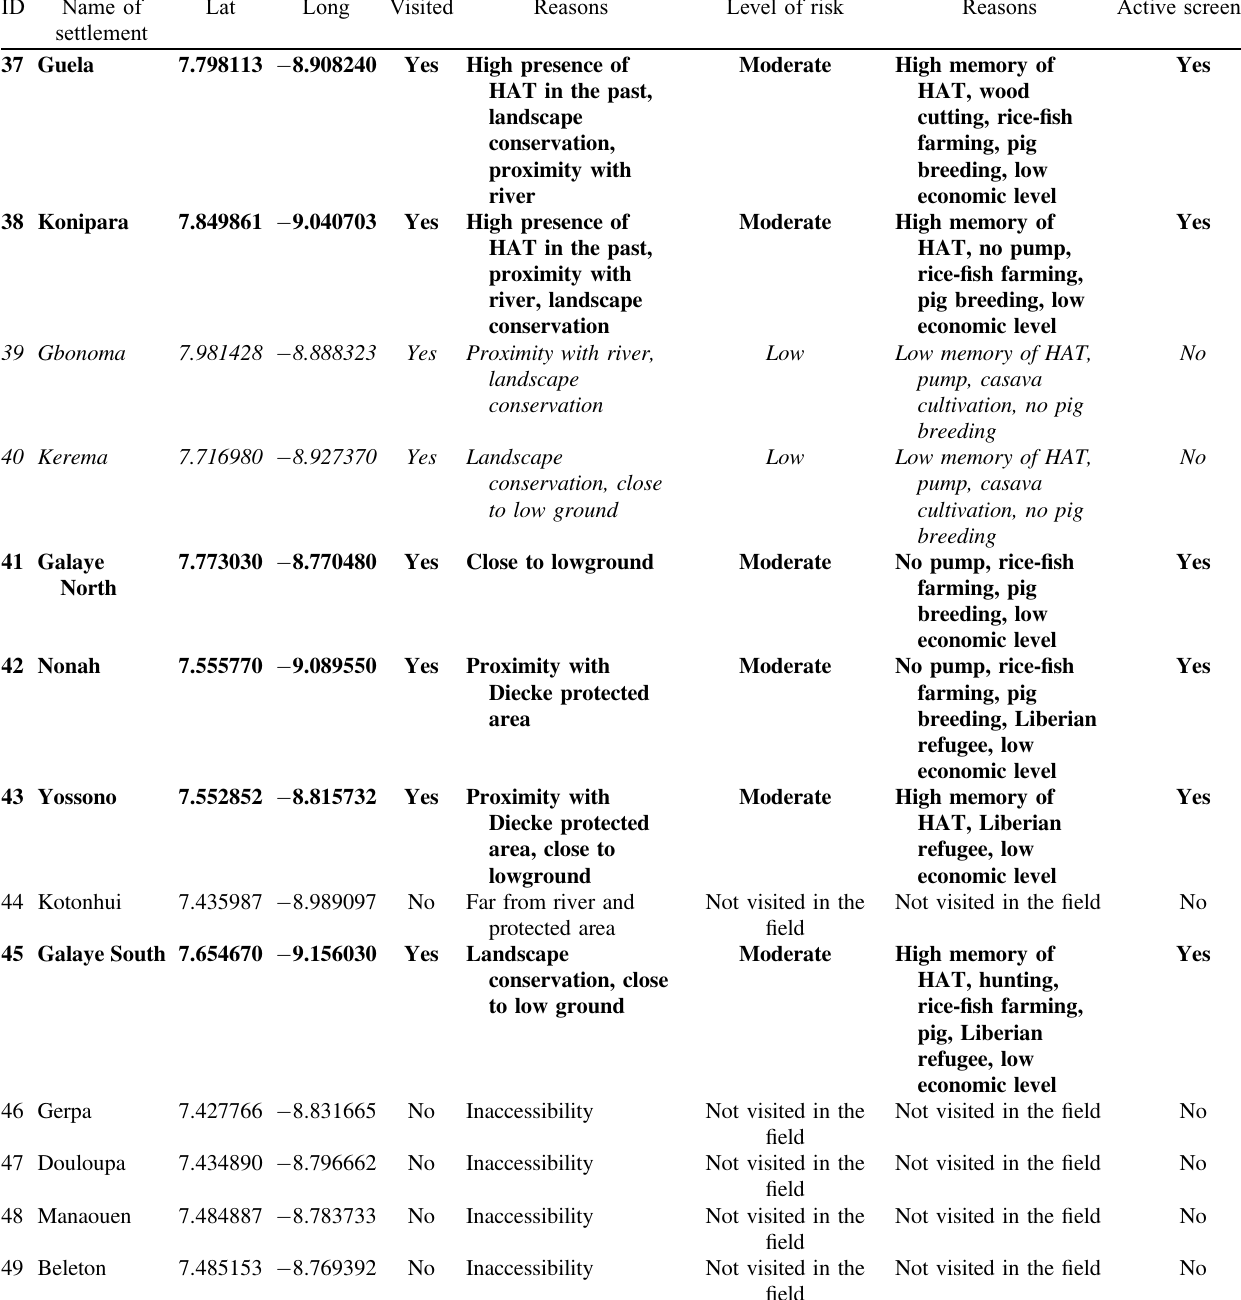
Black: Village selected during IVR-D but not visited in the fi eld during IVR-F. Italic: Village selected during IVR-D and visited on the fi eld during IVR-F. Bold: Village visited during IVR-D, visited in the fi eld during IVR-F and selected for active